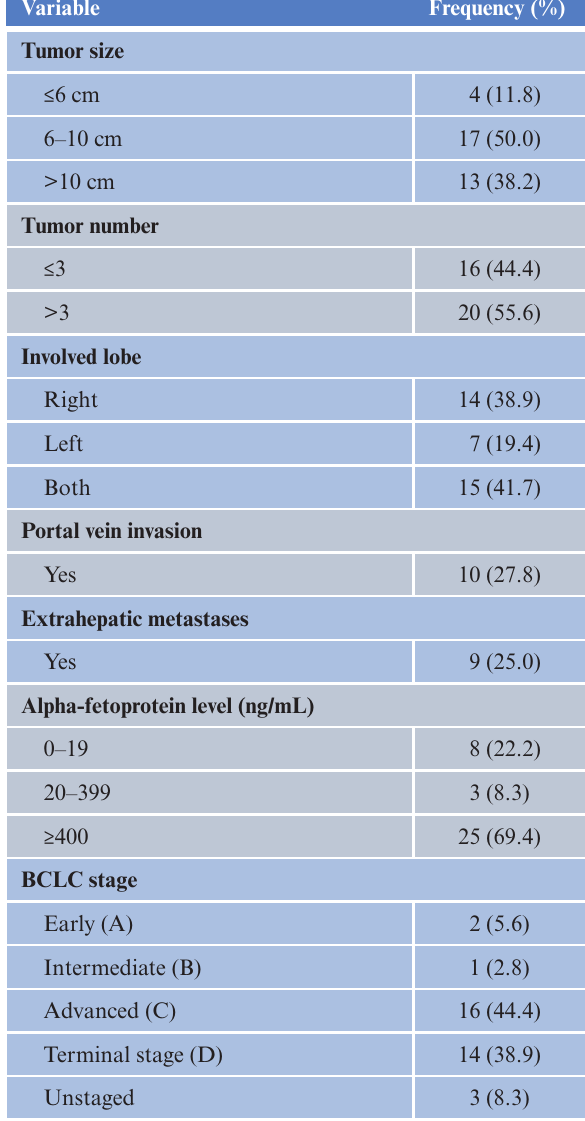
Table 2: Tumor-related